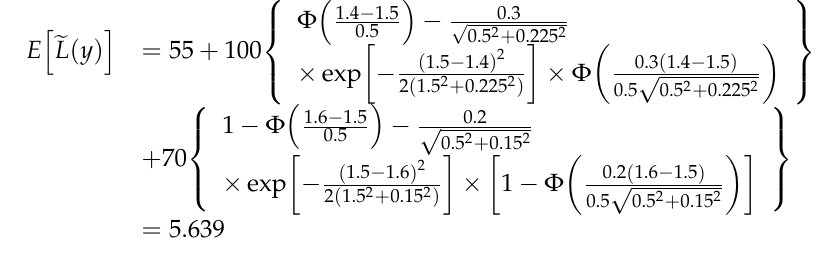
Figure 8. Curve of quality gain-loss function (cid:101) L